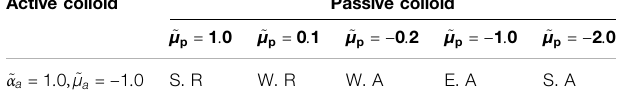
TABLE 1 | Phoretic interaction applied to passive colloids by active colloids with different surface parameters (S. R., strong repulsion; W. R., weak repulsion; W. A., weak attraction; E. A., equal attraction; S. A., strong attraction.). Active